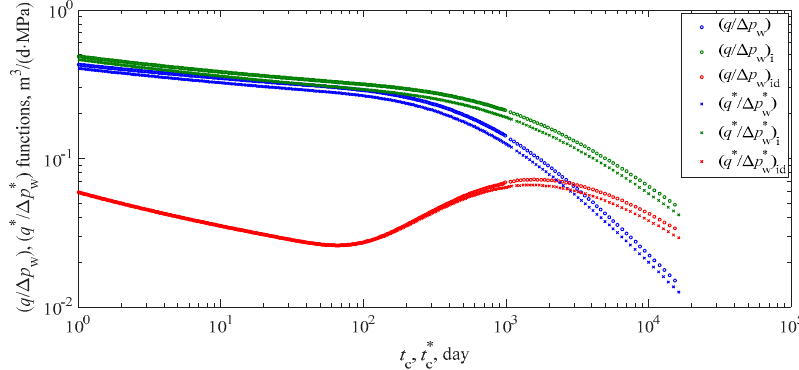
Figure 21. Normalized rate functions and modified normalized rate functions for Case 2.